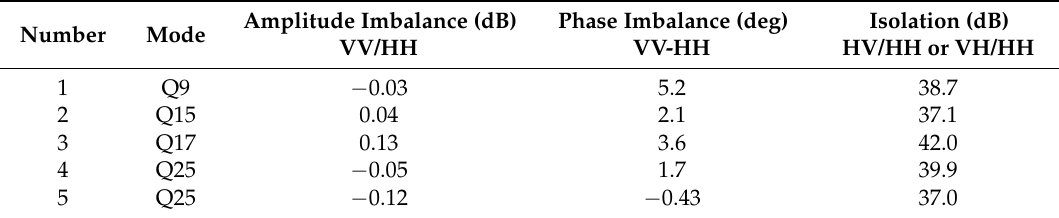
Table 7. Quality assessment results estimated by corner